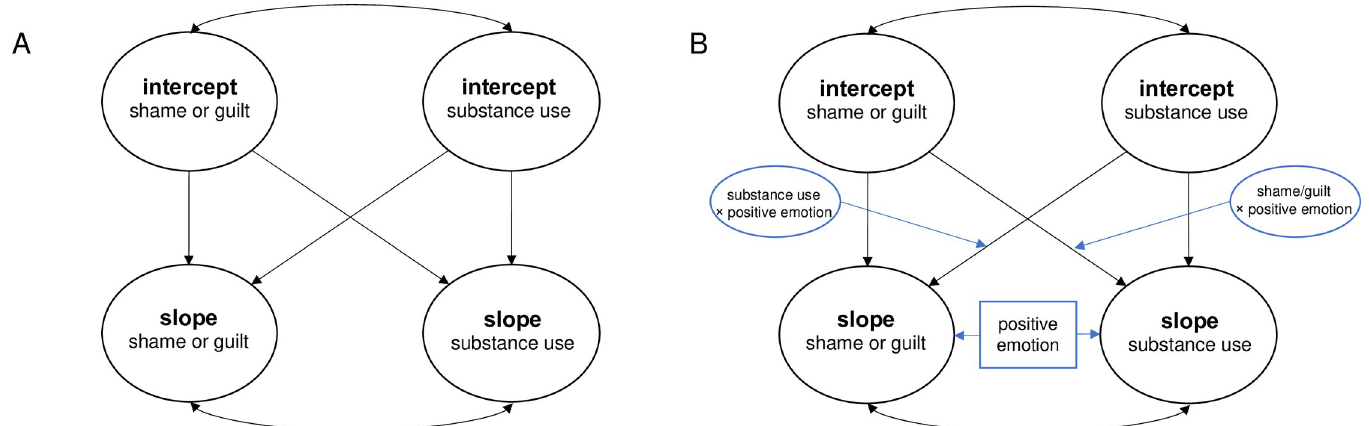
Fig 1. Graphical depiction of models. Notes. The first model (A) represents the initial models tested and the second model (B) represents the models with all the potential paths added for the examination of positive emotion as a moderator. Moderation was explored for any significant diagonal path in the first model (A). The main effects of positive emotion were first examined (including for the intercept to explore cross-sectional association) and then interaction terms entered (with main effect on intercept omitted). Intercepts and slopes were also regressed on covariates not shown in the model. Models also controlled for time invariant covariates including age, being a person of color, income, sexual orientation, time since HIV diagnosis, unstable housing, treatment condition, and time 1 depression.